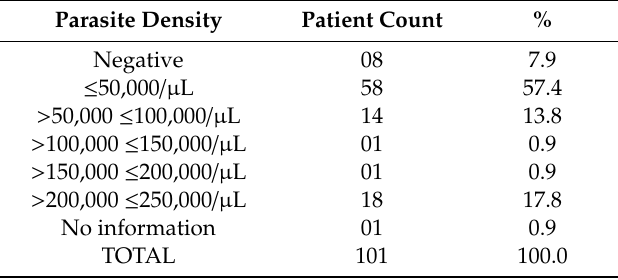
Table 1. Parasitic density of Plasmodium sp. in blood smears of individuals diagnosed with